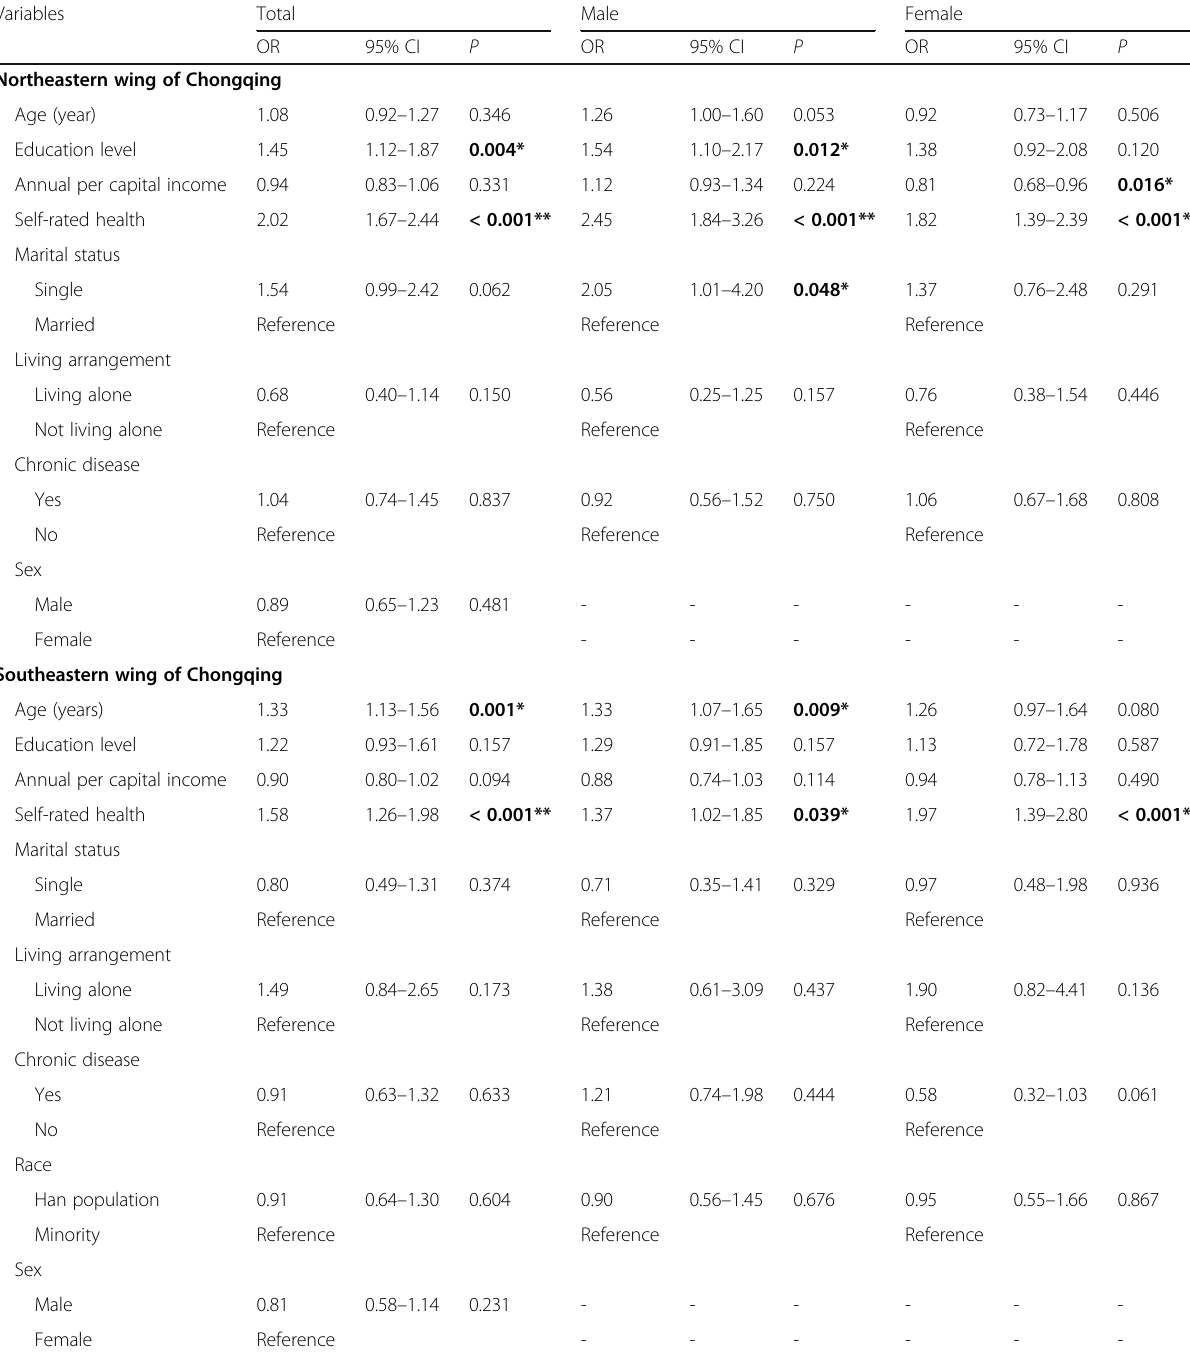
Table 5 Ordered multivariate logistic regression of factors affecting the mental health of the elderly in poverty state counties of Chongqing